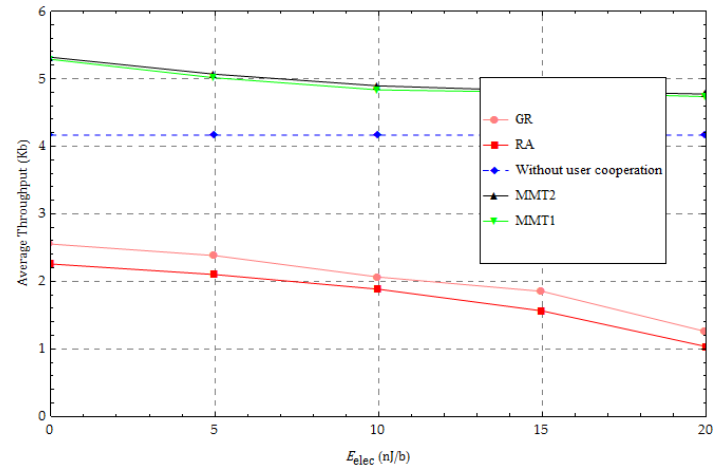
Figure 8. Change in the amount of receiver circuitry.